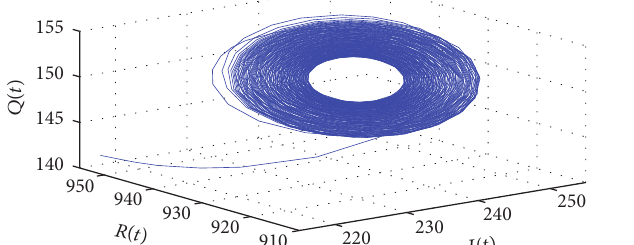
Figure 12: The projection of the phase portrait of system (69) in (𝐼, 𝑄, 𝑅) -space with 𝜏